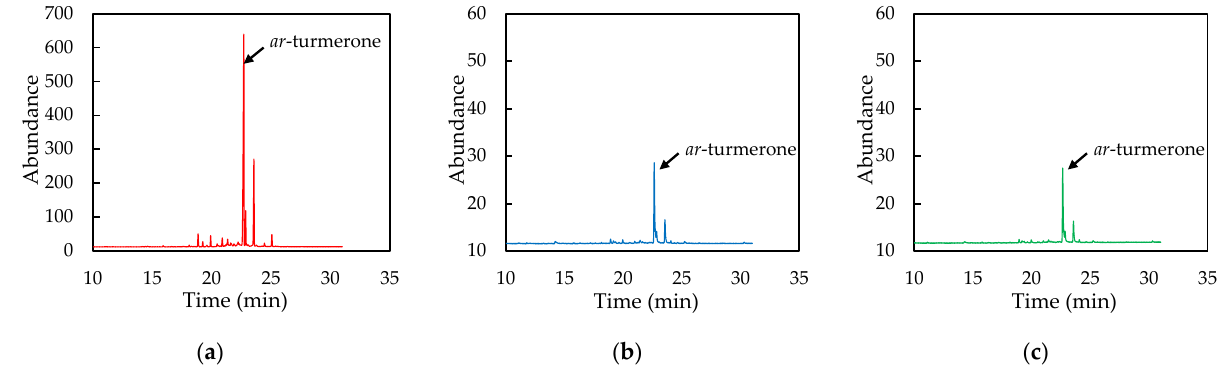
Figure 7. Gas chromatograms of ar-turmerone in TE ( a ), TE-NEs ( b ), and WCS-TE-NEs ( c ).